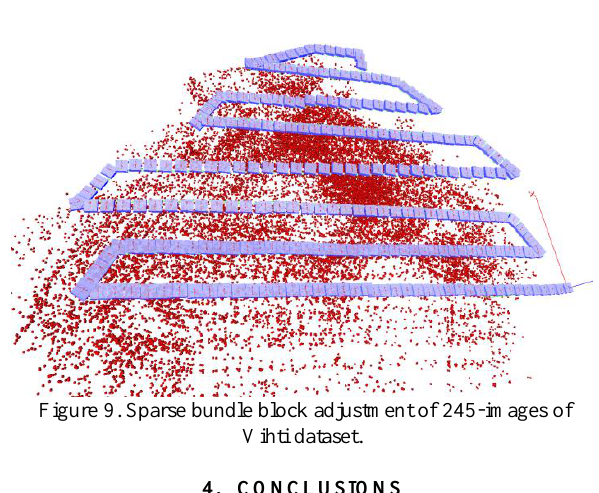
Figure 9. Sparse bundle block adjustment of 245-images of Vihti